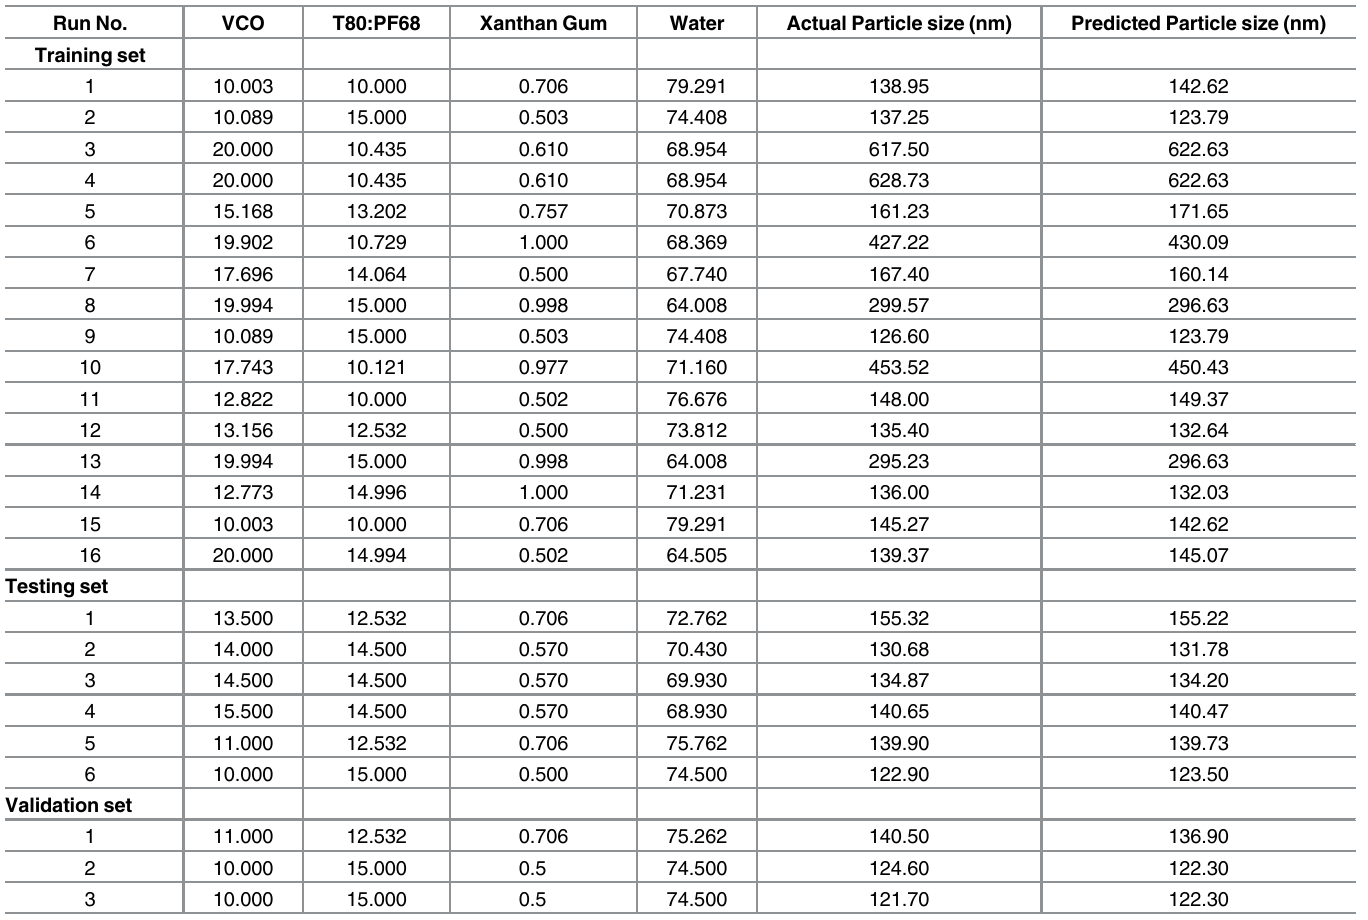
Table 1. The experimental design consists of training, testing and validation data sets; each row indicates an experiment while the columns pres- ent the composition of the VCO nanoemulsions. Run